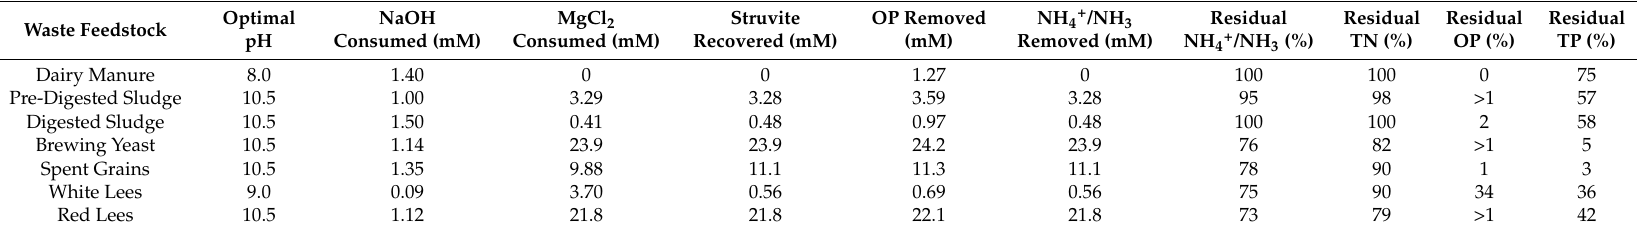
Table 2. Theoretical estimates of struvite recovery and residual total nitrogen (TN) and total phosphorus (TP) concentrations from post-HTL ACPs of select waste feedstocks based on equilibrium chemistry modeling using Visual